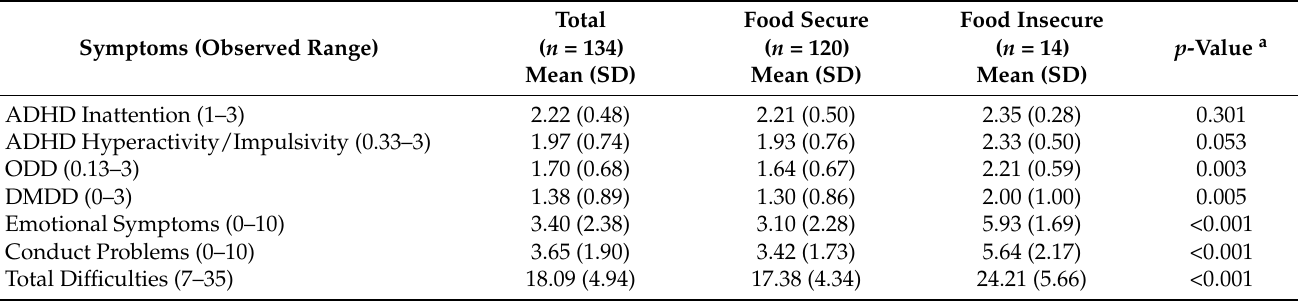
Table 3. Differences in ADHD and emotional dysregulation symptom severity according to household food security status.